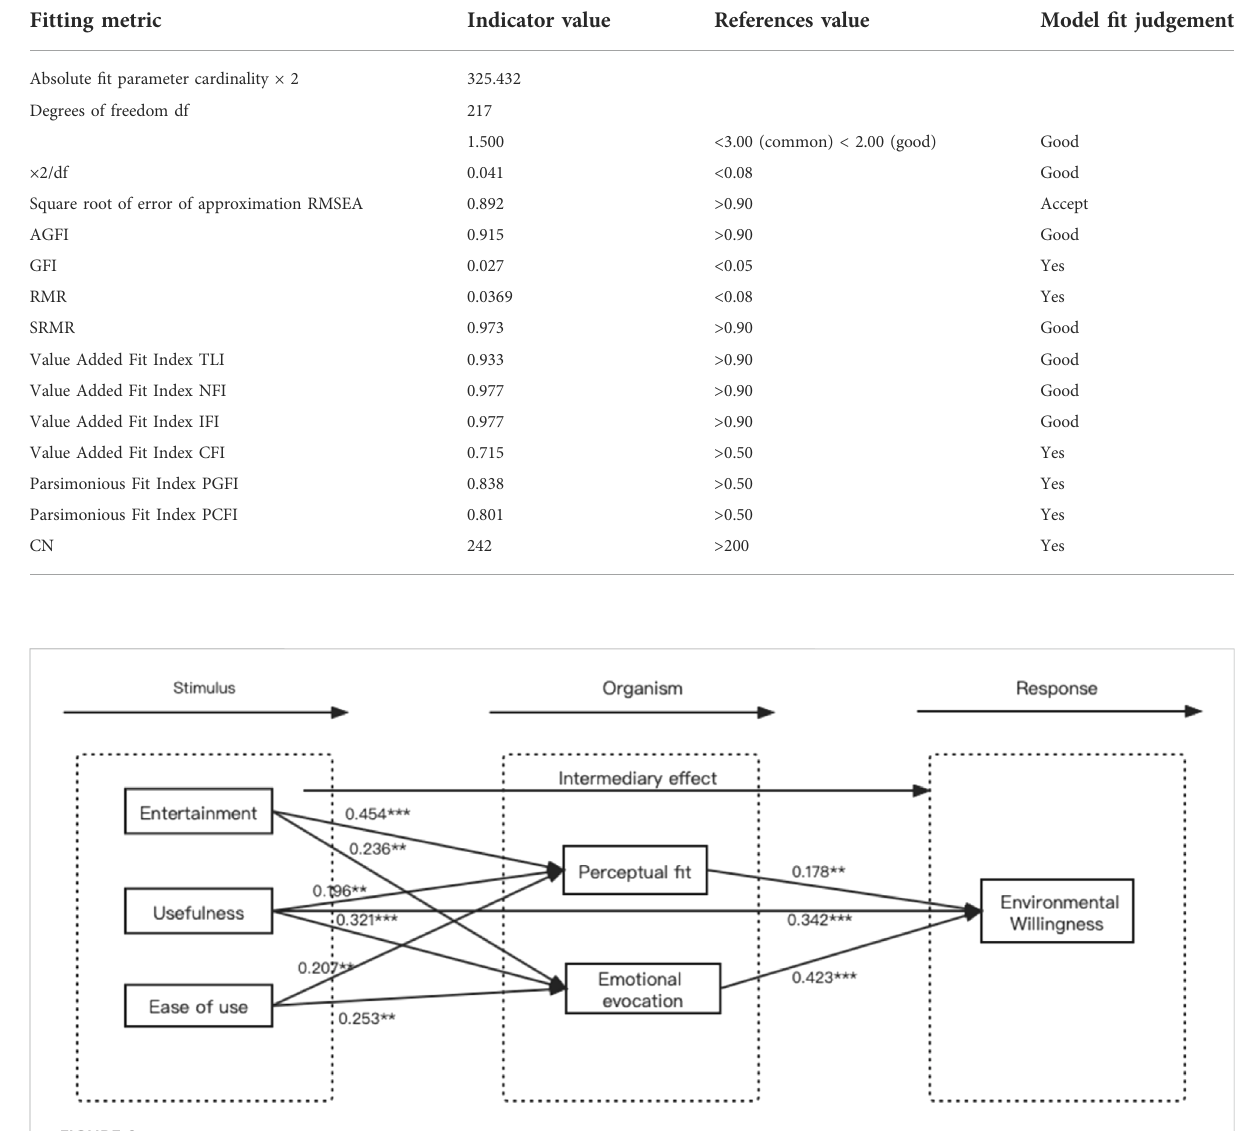
FIGURE 2 Diagram of the model for the study of factors in fl uencing short science videos on individual environmental